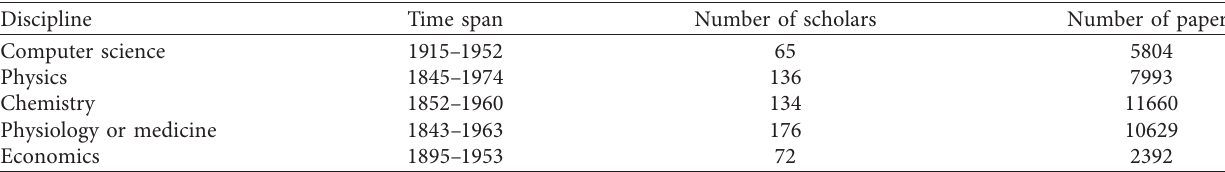
Table 3: Statistical information of the